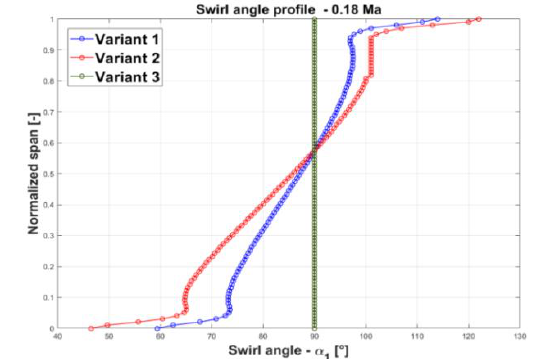
Fig. 3. Profile of circumferential angle 𝛼 1